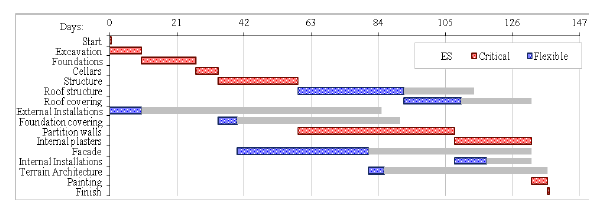
Figure 3: The project baseline schedule.